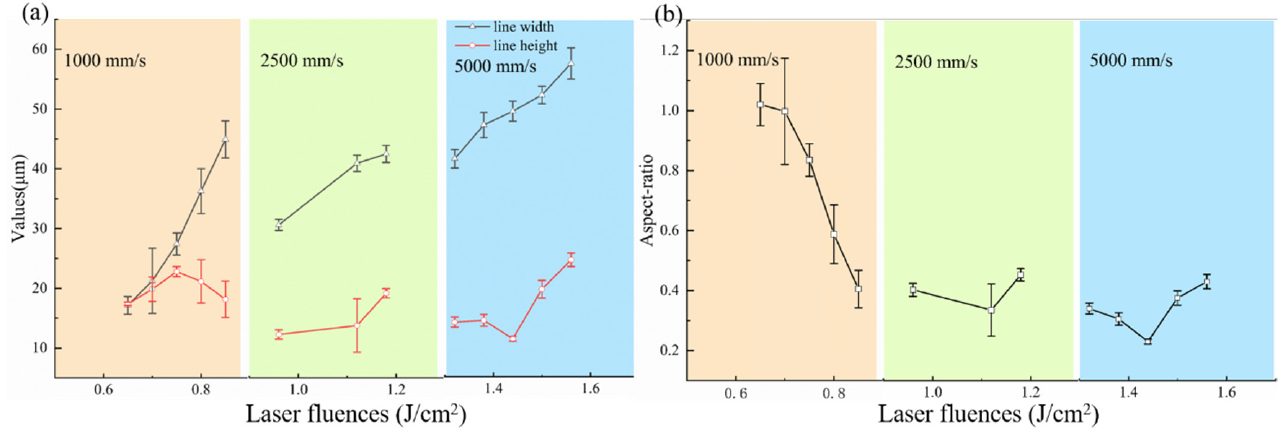
Figure 4. Width, height and aspect-ratio of the formed lines under different laser fluences and processing speeds. ( a ) line width and line height, ( b ) aspect-ratio of the formed line.